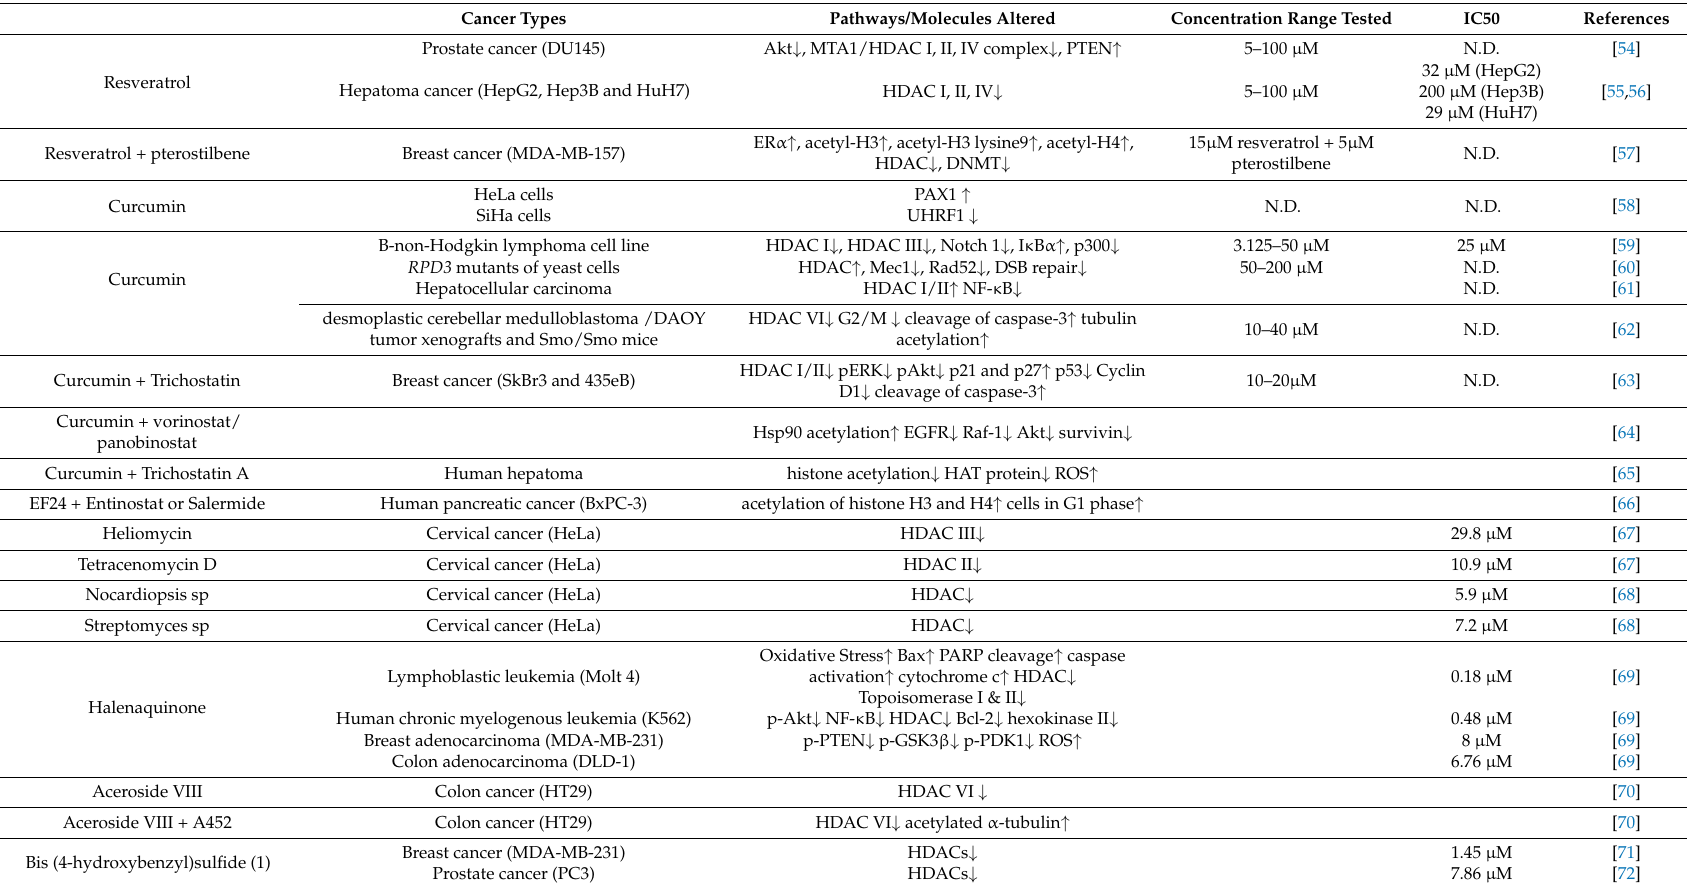
Table 1. Modulation of HDAC activity by selected natural products in tumor